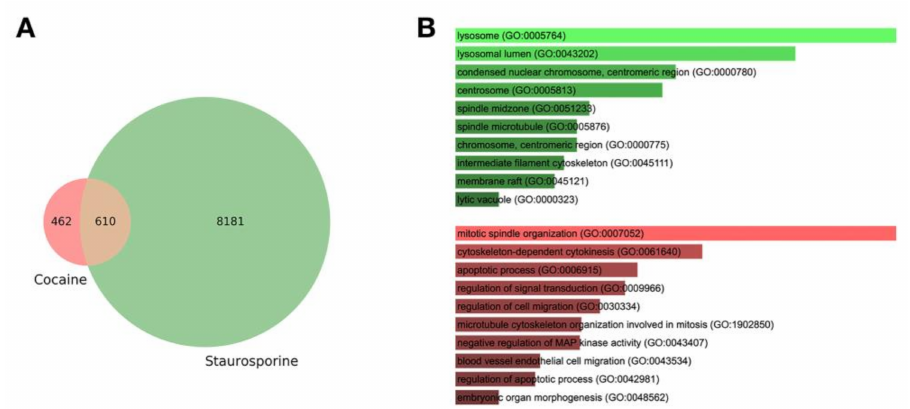
Figure 3. ( A ) Differentially expressed genes upon cocaine administration. The Venn diagram shows the number of genes that are regulated at increasing dose of cocaine or staurosporine. Genes were selected at q < 1 × 10 − 3 ; out of 1072 genes, only 462 were found specific for cocaine. ( B ) Gene Ontology analysis. The bar chart shows the top 10 GO:BP (gene ontology:biological process) categories enriched for the genes specifically induced by cocaine. A large fraction of terms is related to apoptosis.